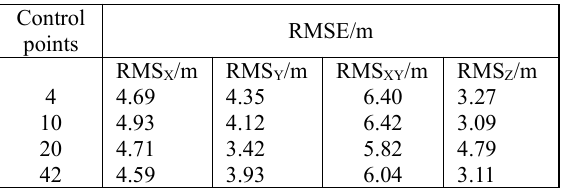
Table 3. The stereo positioning accuracy after attitude quaternion correction